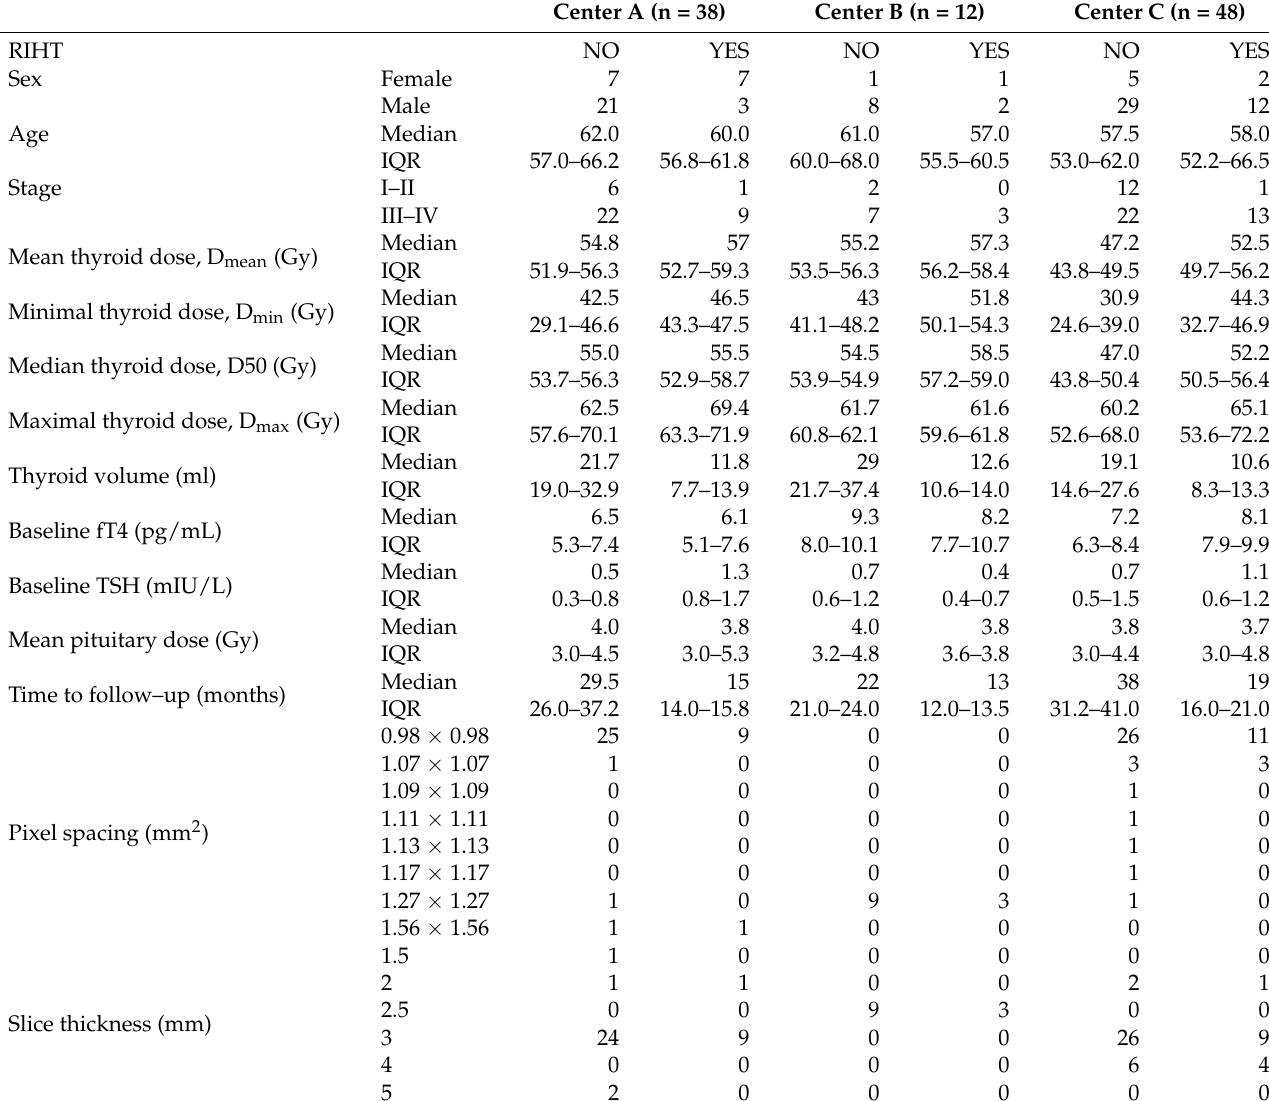
Table 1. Patient, disease and CT images